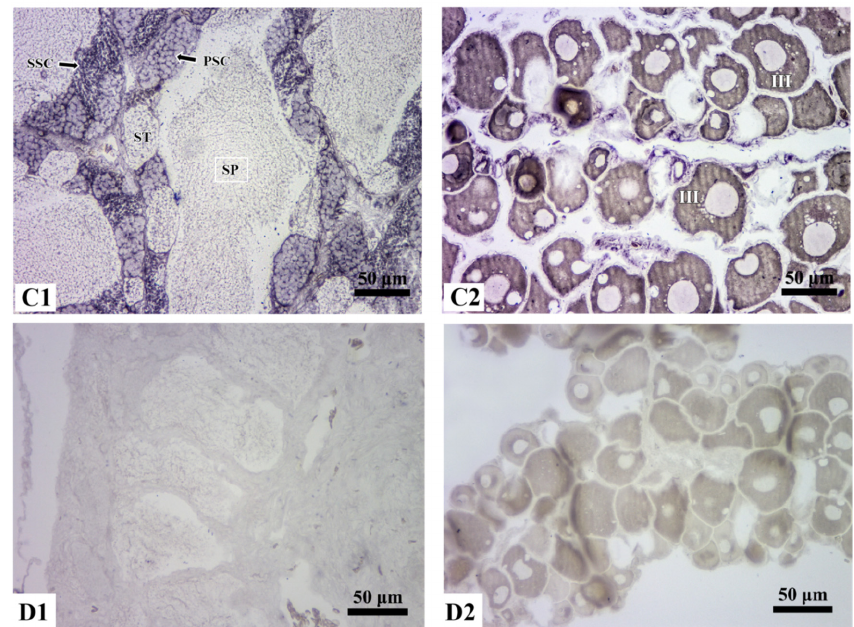
Figure 5. Distribution of Rcvasa mRNA at different developmental stages in cobia gonads, analyzed by CISH. ( A1 , B1 , C1 ), sections of testes at 120 dph, 210 dph, and 360 dph were hybridized with an Rcvasa oligonucleotides probe; ( A2 , B2 , C2 ), sections of ovaries at 120 dph, 210 dph, and 360 dph were hybridized with an Rcvasa oligonucleotides probe. ( D1 , D2 ), negative control, sections of testes and ovaries at 210 dph, hybridized with a sense probe. SG: spermatogonia; PSC: primary spermatocyte; SSC: secondary spermatocyte; ST: spermatid; SP: spermatozoa; OG: oogonium (chromatin nucleolar oocyte); I: oocyte at stage I (perinucleolar oocyte); II: oocyte at stage II (previtellogenic oocyte); III: oocyte at stage III (vitellogenic